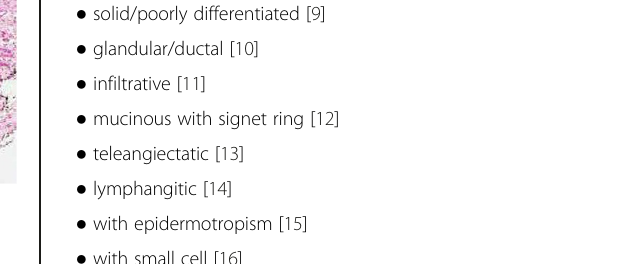
Table 1 Cutaneous metastasis of prostatic adenocarcinoma: morphological